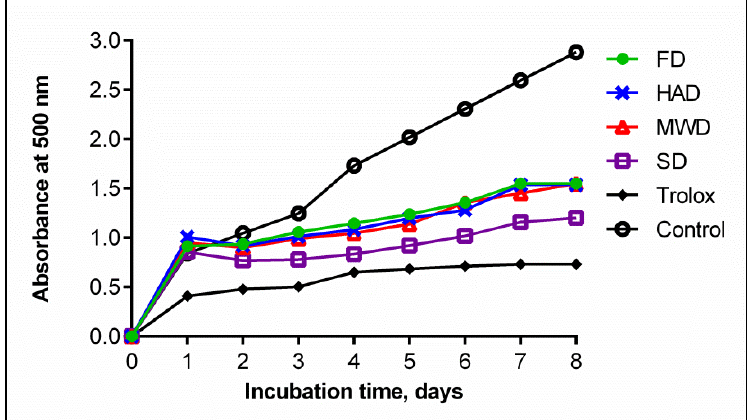
Figure 6. Lipid peroxidation inhibition of dry fruiting bodies Pleurotus ostreatus after in vitro digestion. Lower absorbance at 500 nm represents higher lipid peroxidation inhibition. FD—freeze drying; HAD —hot air drying; MWD—microwave drying; SD—sun drying.